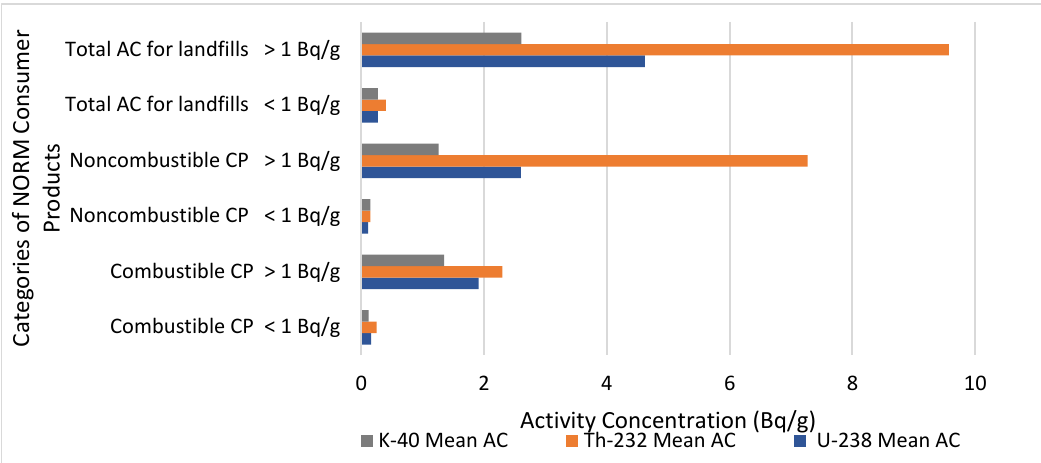
Figure 1. 95% confidence interval for the mean activity concentration of 238 U, 232 Th, and 40 K (Bq/g).